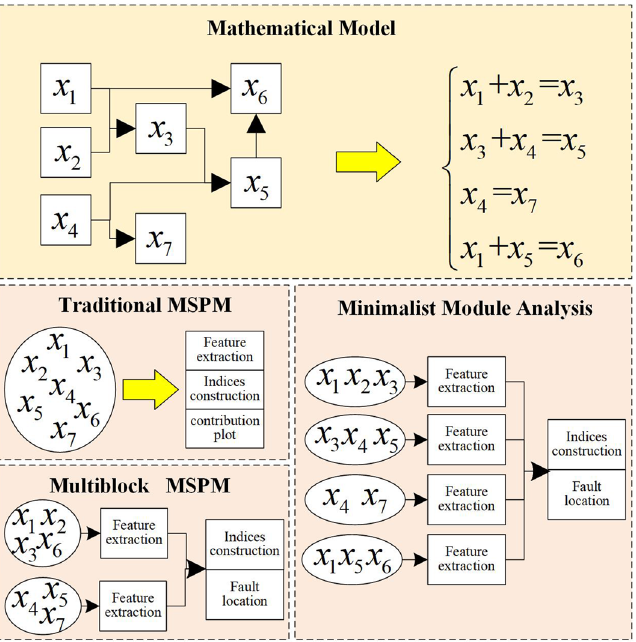
Figure 1. The traditional multivariate statistical-based process monitoring (MSPM) methods, multiblock MSPM, and minimalist module